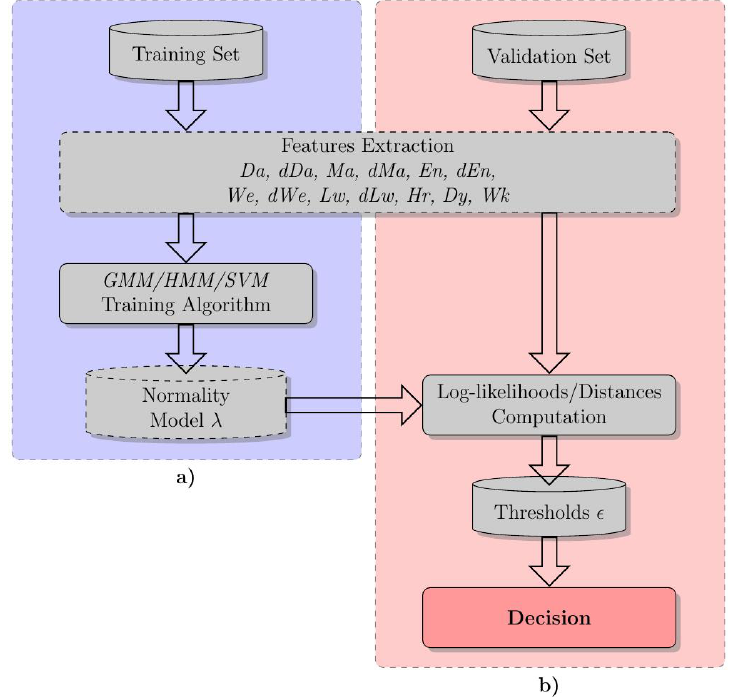
Figure 1. Framework stages: ( a ) normality model creation; ( b ) novelty